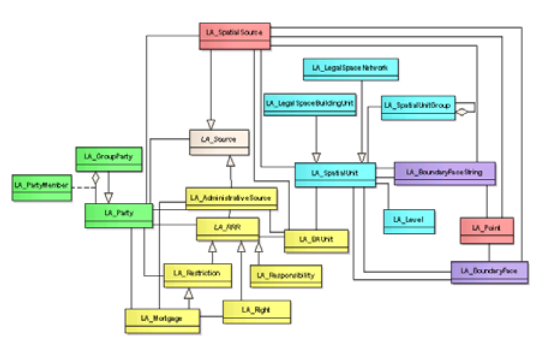
Figure 3. The Land Administration Domain Model (Lemmen and Oosterom 2013).